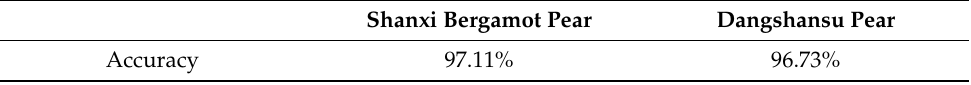
Table 7. Accuracy of detection of two pear varieties that have not been trained on the